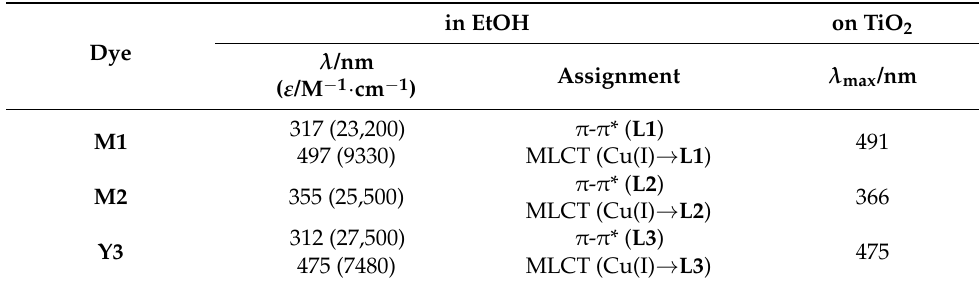
Figure 2. ( a ) UV-vis spectra of M1 , M2 , and Y3 in EtOH and ( b ) their DR spectra on TiO 2 . Table 1. UV-vis and DR spectroscopic data for M1 , M2 , and Y3